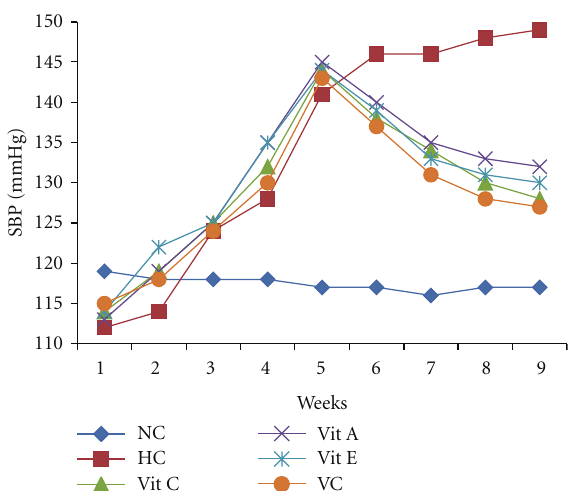
Figure 2: E ff ect of salt diet and antioxidant supplementation on systolic blood pressure of salt-loaded rat. week 1–5: salt diet only, week 6–9: -salt diet plus supplements, NC—normotensive, HC—hypertensive control, Vit C—salt loaded treated with vitamin C, Vit A—salt loaded treated with vitamin A, Vit E—salt loaded treated with vitamin E, and VC—salt loaded treated with vitamins combined.